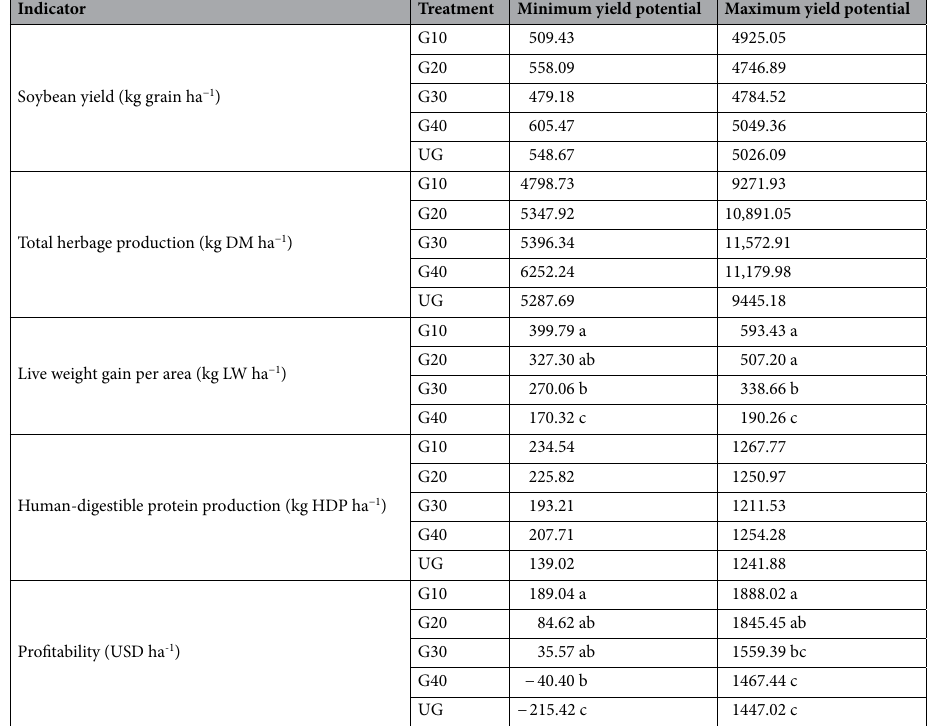
Table 2. Minimum and maximum yield potentials of a long-term (2001–2016) soybean system integrated with livestock at different grazing intensities or left ungrazed in the winter period. G10: intense grazing (10 cm sward height); G20: moderate grazing (20 cm sward height); G30: moderate-light grazing (30 cm sward height); G40: light grazing (40 cm sward height); UG: ungrazed cover crop. Different letters in the column represent significant differences among treatments according to the Tukey test ( ⍺ =